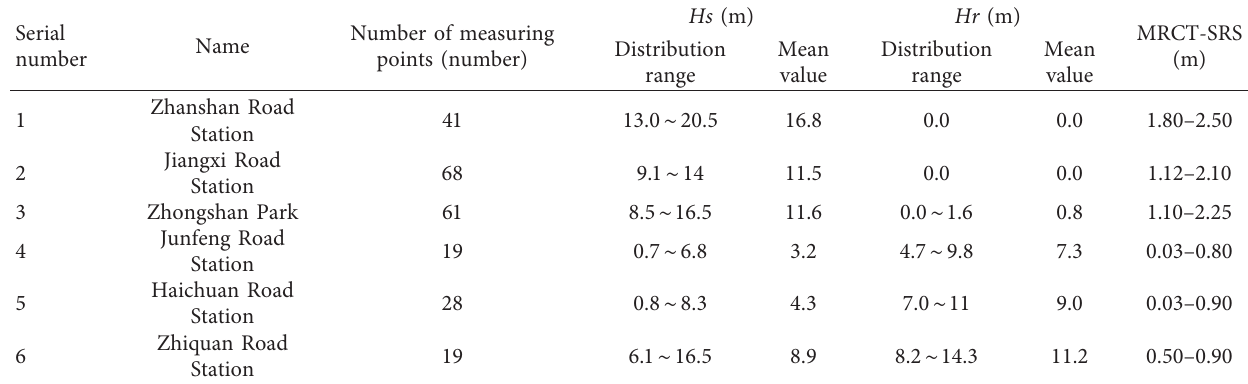
Table 8: Basic overview of metro station tunnel.